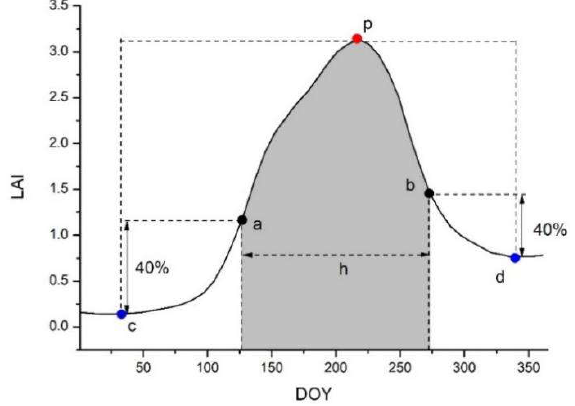
Figure 2. Seasonal parameters: ( a ) start of season, ( b ) end of season, ( c ) minimum Leaf Area index (LAI) value in the left, ( d ) minimum LAI value in the right, ( h ) length of season, ( p ) peak. (DOY means day of year).